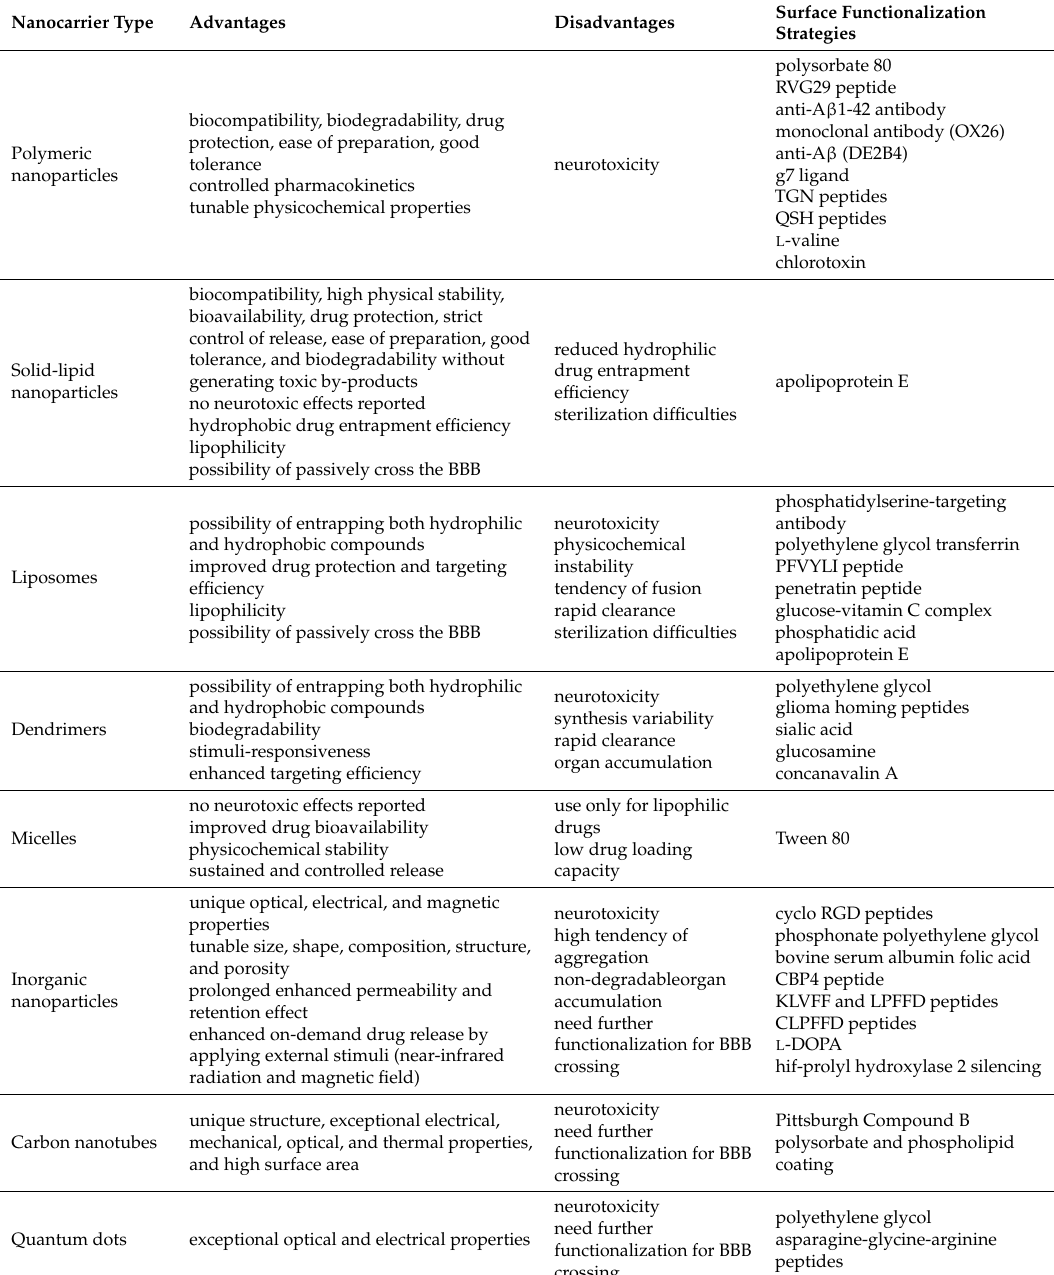
Table 1. The main advantages, disadvantages, and surface functionalization strategies for the organic and inorganic